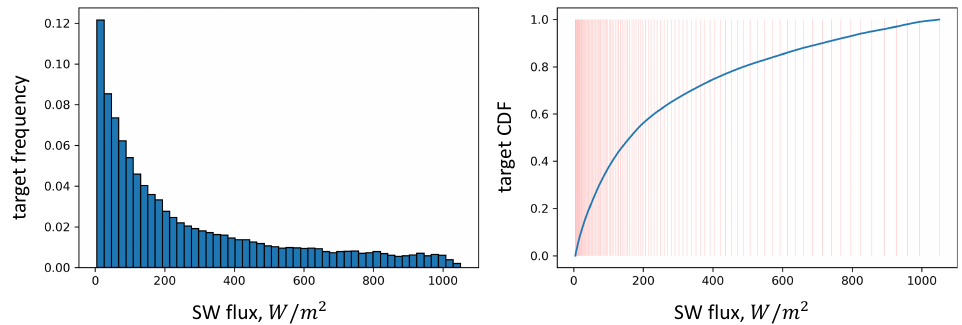
Figure 4. Dataset target (SW radiation flux) distribution (histogram) and approximated cumulative density function (right panel). One may clearly see the imbalance of the dataset w.r.t. target value. We present the percentiles in the CDF figure using vertical red lines in order to demonstrate the inter-percentile